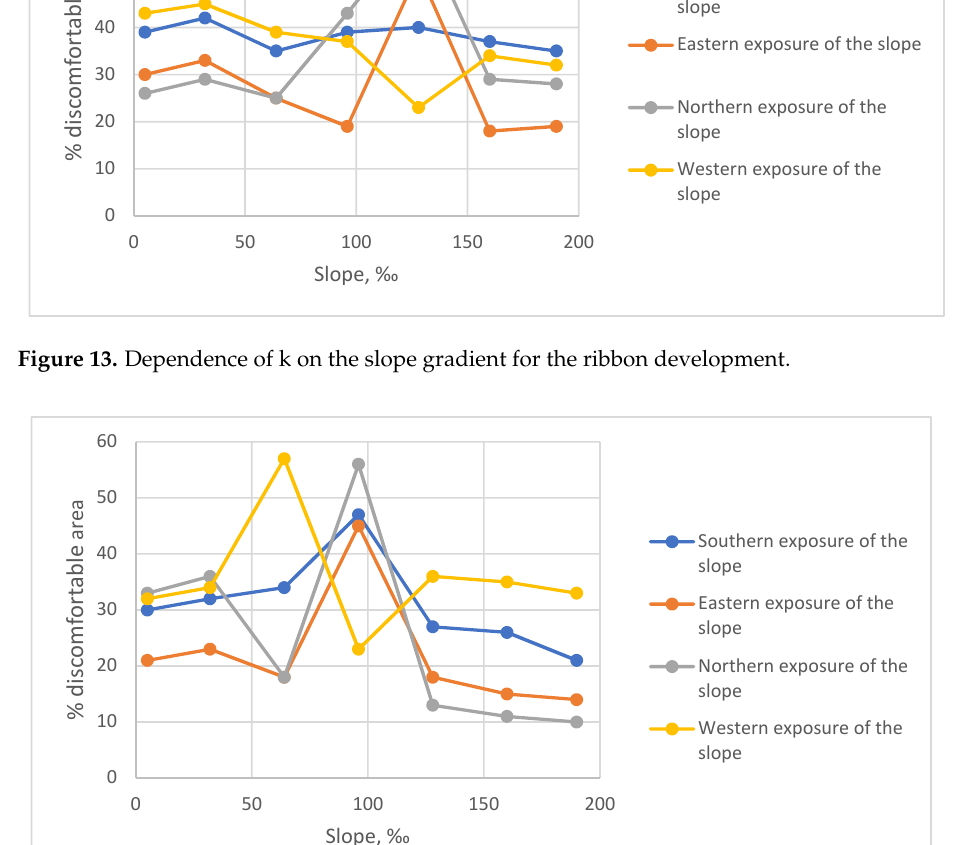
Figure 14. Dependence of k on the slope gradient for the sporadic type of development. When wind flows in the sporadic morphotype of development are simulated, a larger share of discomfortable zones becomes more pronounced if the gradient is intermediate (Figure 14). It varies from 60–160‰ for this morphotype. There is more than a twofold increase in k there, if slopes face south, north, and east. However, on west-facing slopes an increase in k is observed at a gradient of 45–90‰, while if the gradient is 60 to 160‰ a decrease is observed. This effect is associated with the planning features of the develop- ment model.